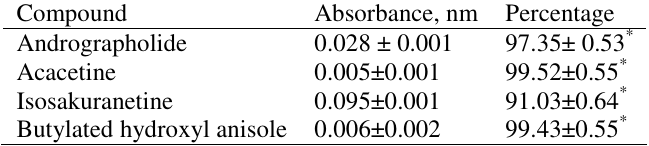
Table 3. Free radical scavenging activities of isolated